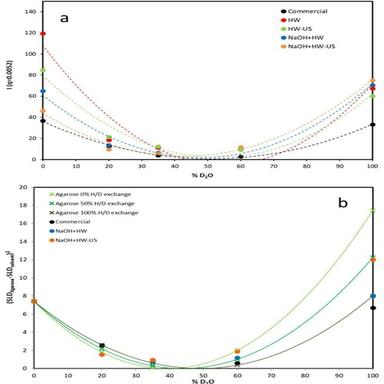
(a) Contrast variation curves for the agar-based extracts, obtained from the SANS experiments. Solid markers represent the experimental values (q = 0.0052Å−1) and dotted lines correspond to the fitted parabolic functions. (b) Representation of the scattering length density contrast term (SLDAgarose-SLDsolvent) 2 as a function of the D2O content of the different solvent mixtures used for the contrast variation experiments. Dots represent the experimental values for the agar gels and crosses represent the the